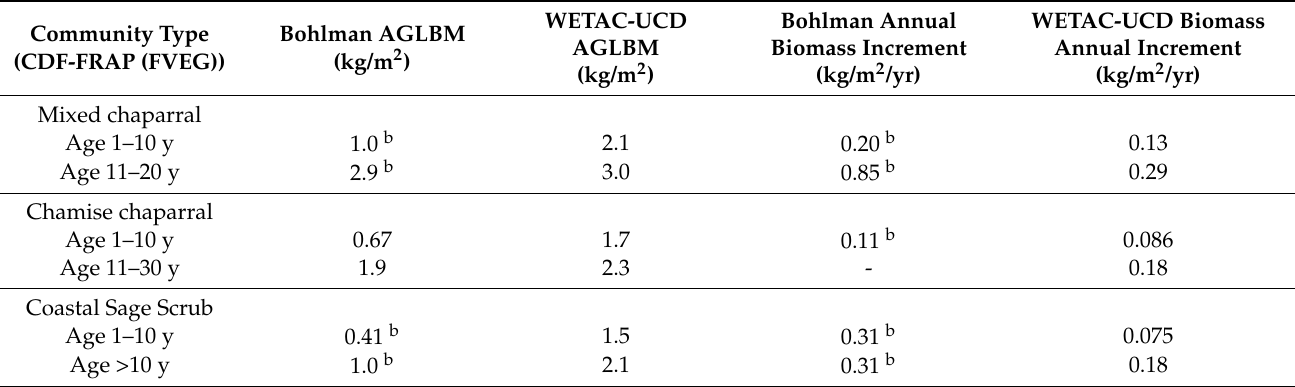
Table 5. Aboveground live biomass (AGLBM) and mean annual biomass increment (growth) values estimated by the WETAC-UCD model for the three CWHR vegetation types and two age classes presented in Bohlman [17]. WETAC-UCD values were extracted from the Station (2009) and Pechanga (2000) fires. Bohlman [17] summarized AGLBM and increment data from a literature search of 37 studies spanning 72